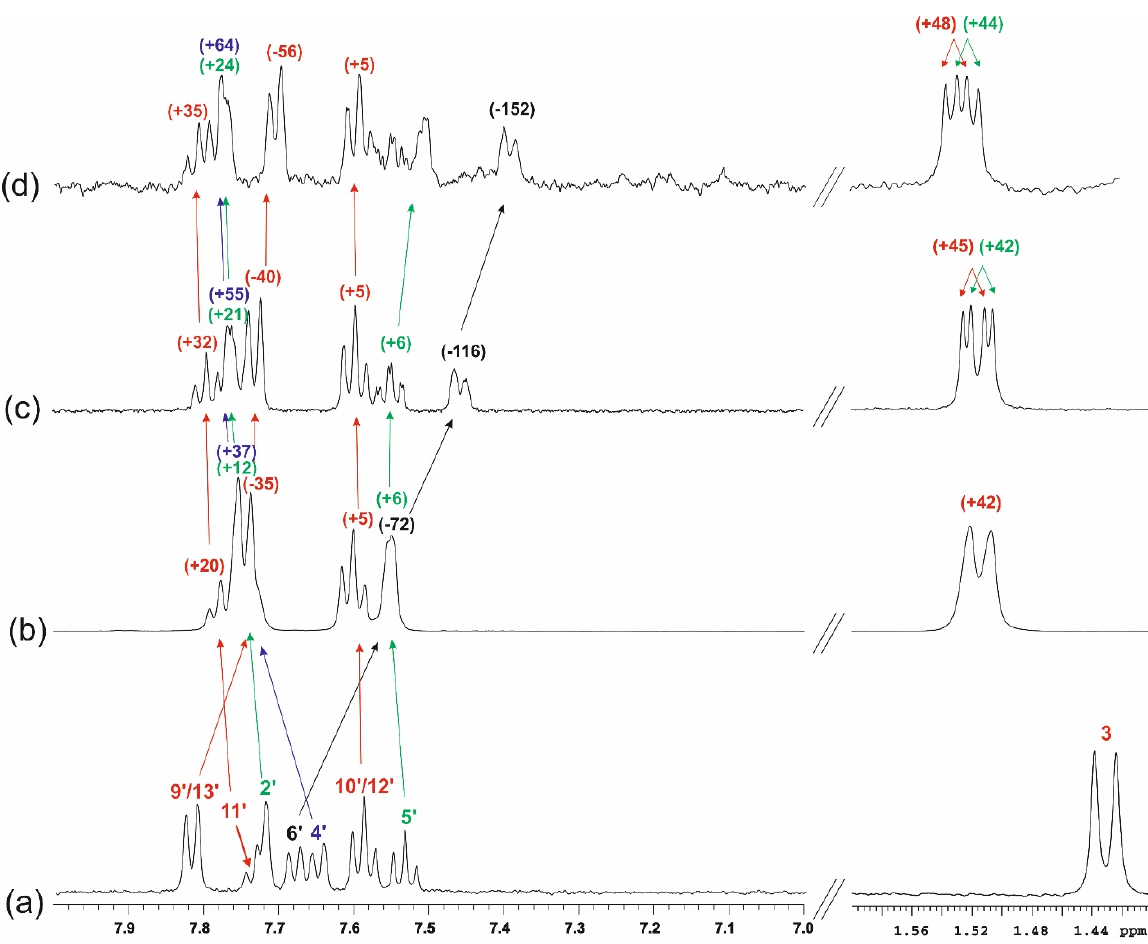
Figure 11. The fragments of the 1 H NMR spectra (7.0–8.0 ppm and 1.4–1.6 ppm) of: racemic KP aqueous solutions, C KP = 0.050 m M (a), sample 3 , C β -CD = C KP = 1.22 m M (b), sample 1 , C β -CD = 3.42 m M , C KP = 0.34 m M (c), sample 2 , C β -CD = 3.73 m M C KP = 0.05 m M (d); in brackets, Δδ are given ( Δδ = δ obs − δ 0 is the chemical shift change of proton signals of KP, δ obs = the chemical shift of proton signals of KP at the presence of β -CD at given concentration, δ 0 = the chemical shift of proton signals of KP at 0.050 m M ; negative values indicate low-frequency shift, (Hz)); chemical shift changes of aromatic protons of rings A and B are marked in green and red, respectively; temperature of 25 °C.